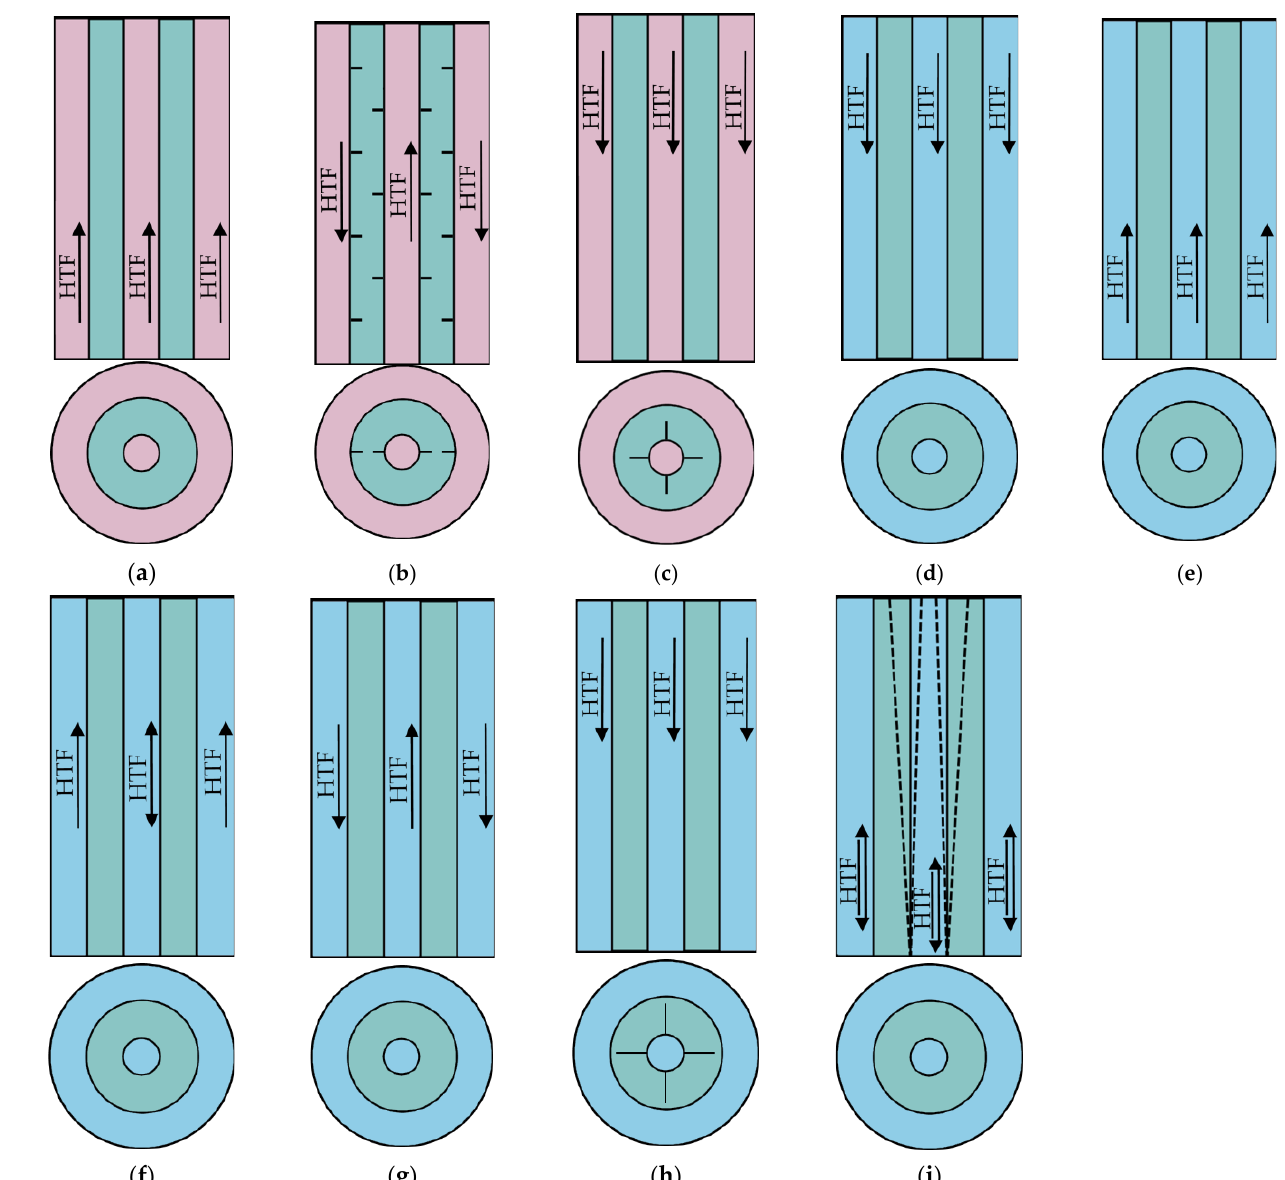
Figure 4. Horizontal triplex-tube arrangements; ( a ) Case TTH-M; ( b ) Case TTH-ILF-M; ( c ) Case TTH-ELF-M; ( d ) Case TTH-ILF+ELF-M; ( e ) Case TTH-AF-M; ( f ) Case TTH-ILF+ELF-AT-M; ( g ) Case TTH-FO-M; ( h ) Case TTH-S; ( i ) Case TTH-ILF-S; ( j ) Case TTH-ELF-S; ( k ) Case TTH-ILF+ELF-M; ( l ) Case TTH-EH-M+S; ( m ) Case TTH-IH-M+S; ( n ) Case TTH-IH-ILF+ELF-M+S; ( o ) Case TTH-ILF-MP- M+S; ( p ) Case TTH-WT-S.